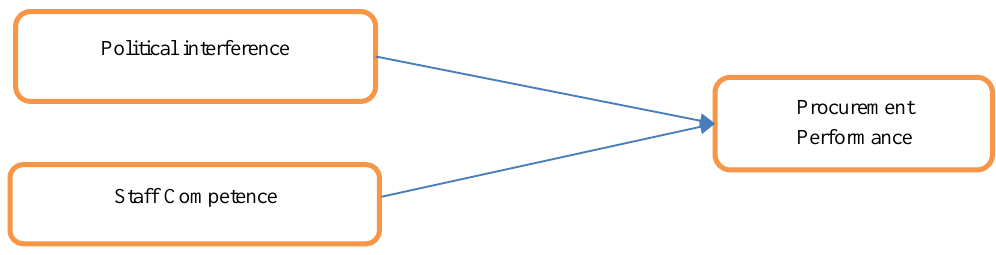
Figure 1: Conceptual framework; Source: Authors, (2022).